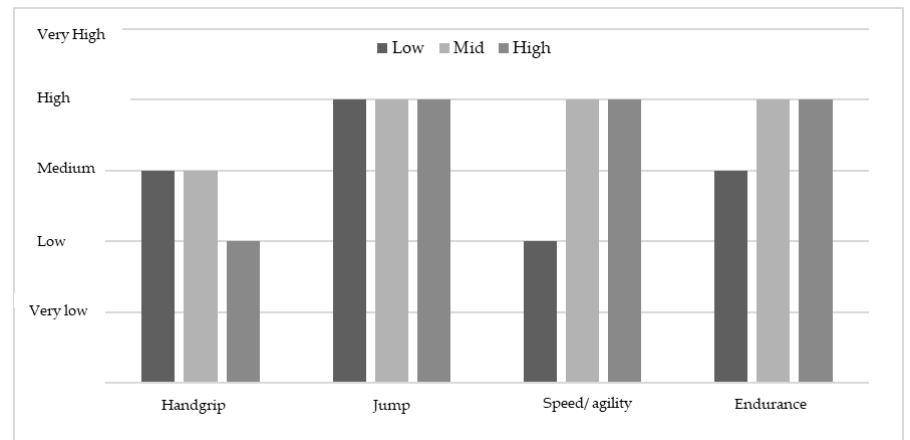
Figure 6. Mean levels of the physical fitness variables in the boys based on the average levels established by Ortega et al. (2011) [59].